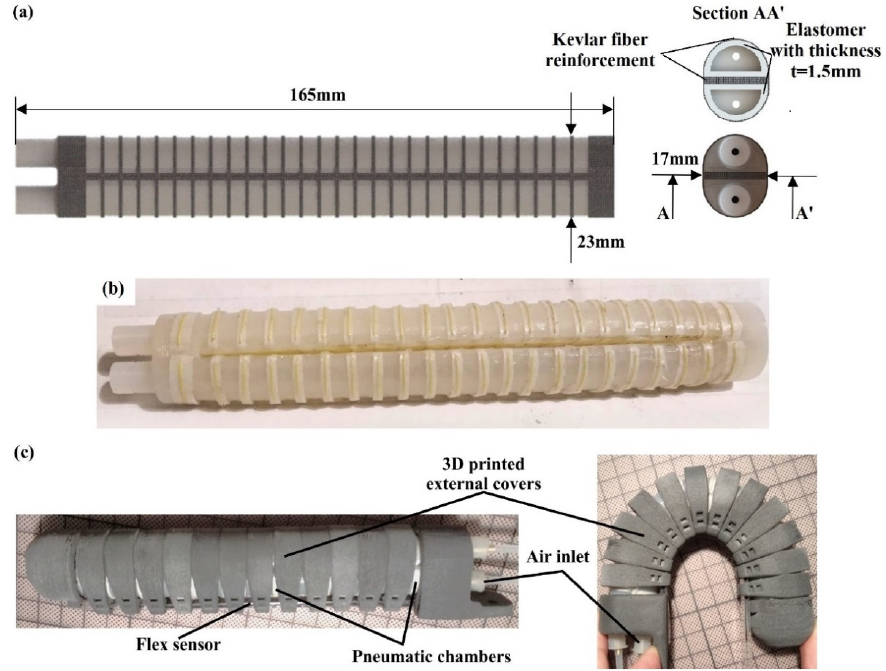
Figure 3. ( a ) 3D design; ( b ) Physical model of the actuator’s core; ( c ) Final configuration of the developed actuator for the SEG application [28].